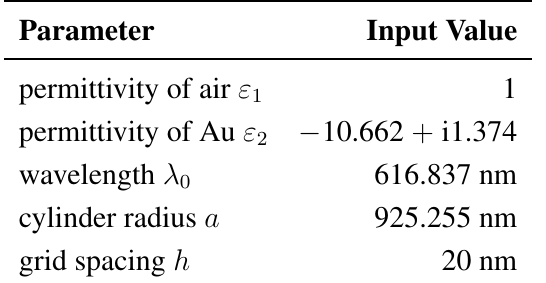
Table 2. Simulation parameters for a Au sphere.